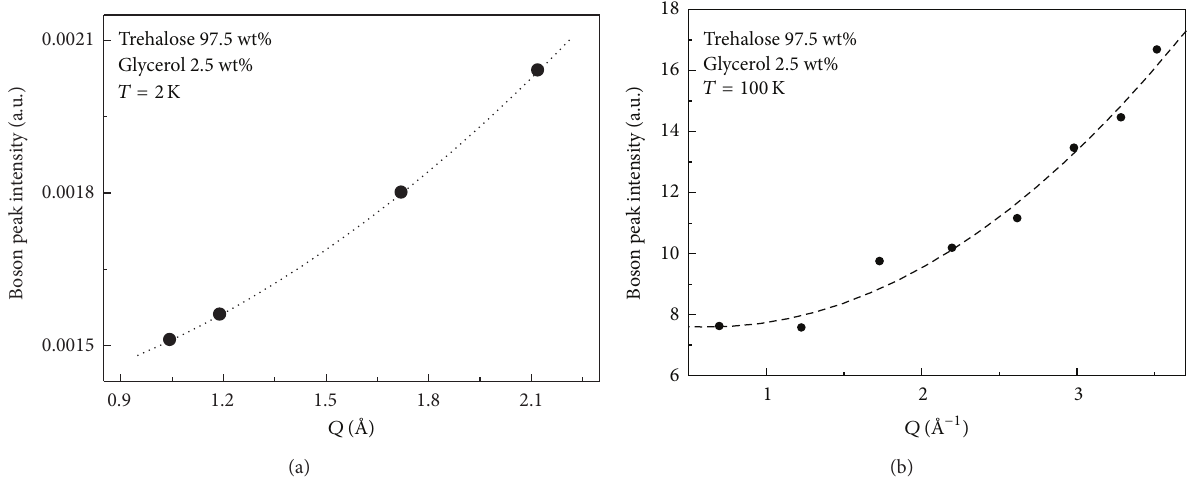
Figure 3: 𝑄 dependence of the Boson peak intensity for a trehalose/glycerol mixture at 2.5 wt% of glycerol as a function of the energy shift for different 𝑄 values at (a) T = 2K and (b) T =